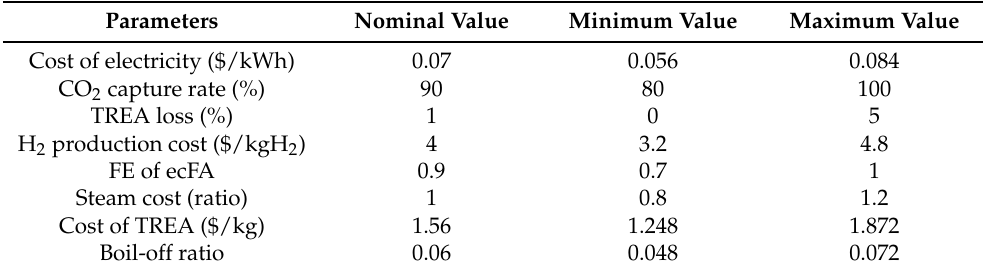
Table 3. Names and value ranges of the parameters subject to change during